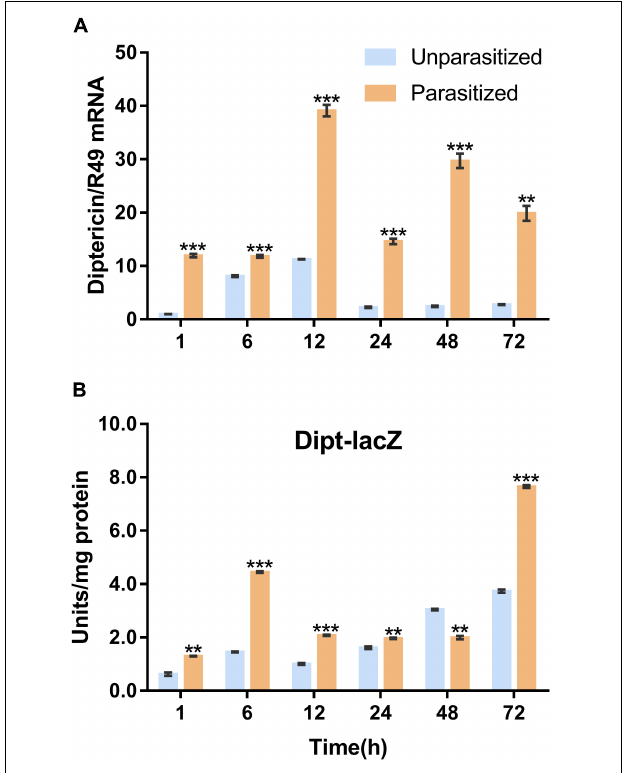
FIGURE 4 | Effects of parasitism on the Toll pathway. (A) mRNA expression levels of drosomycin at 1, 6, 12, 24, 48, and 72 h both in parasitized and unparasitized Drosophila ( n = 3), and ribosomal protein 49 ( R49 ) was used as internal reference. (B) Fluorescence intensity measurement of drosomycin-GFP in parasitized and unparasitized Drosophila based on the time points mentioned above ( n ≥ 10). The fluorescence intensity of 1 h unparasitized was normalized to 1.0. The results are shown as the mean ± standard error; ∗ P < 0.05, ∗∗ P < 0.01, and ∗∗∗ P < 0.001 compared to unparasitized.